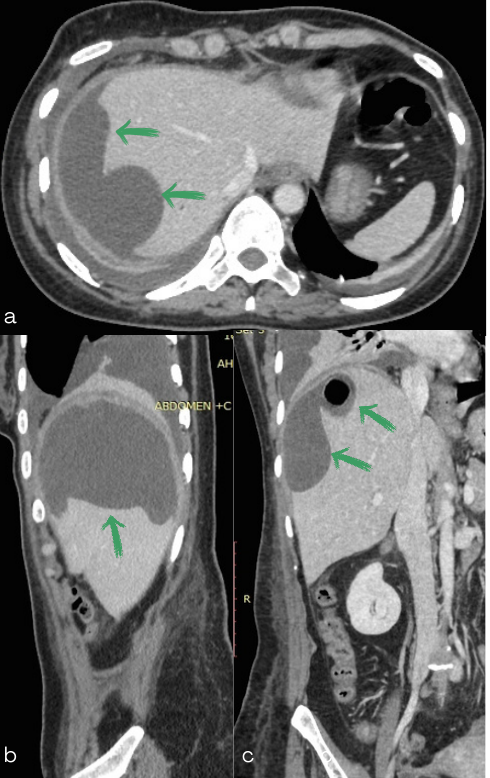
Figure 2. ( a , b ) Computed tomography scan of the abdomen: ( a ) axial, ( b ) sagittal and ( c ) coronal section showing a subcapsular collection as well as a rounded water-attenuation fluid collection with an air–fluid level in contact with the previous one (green